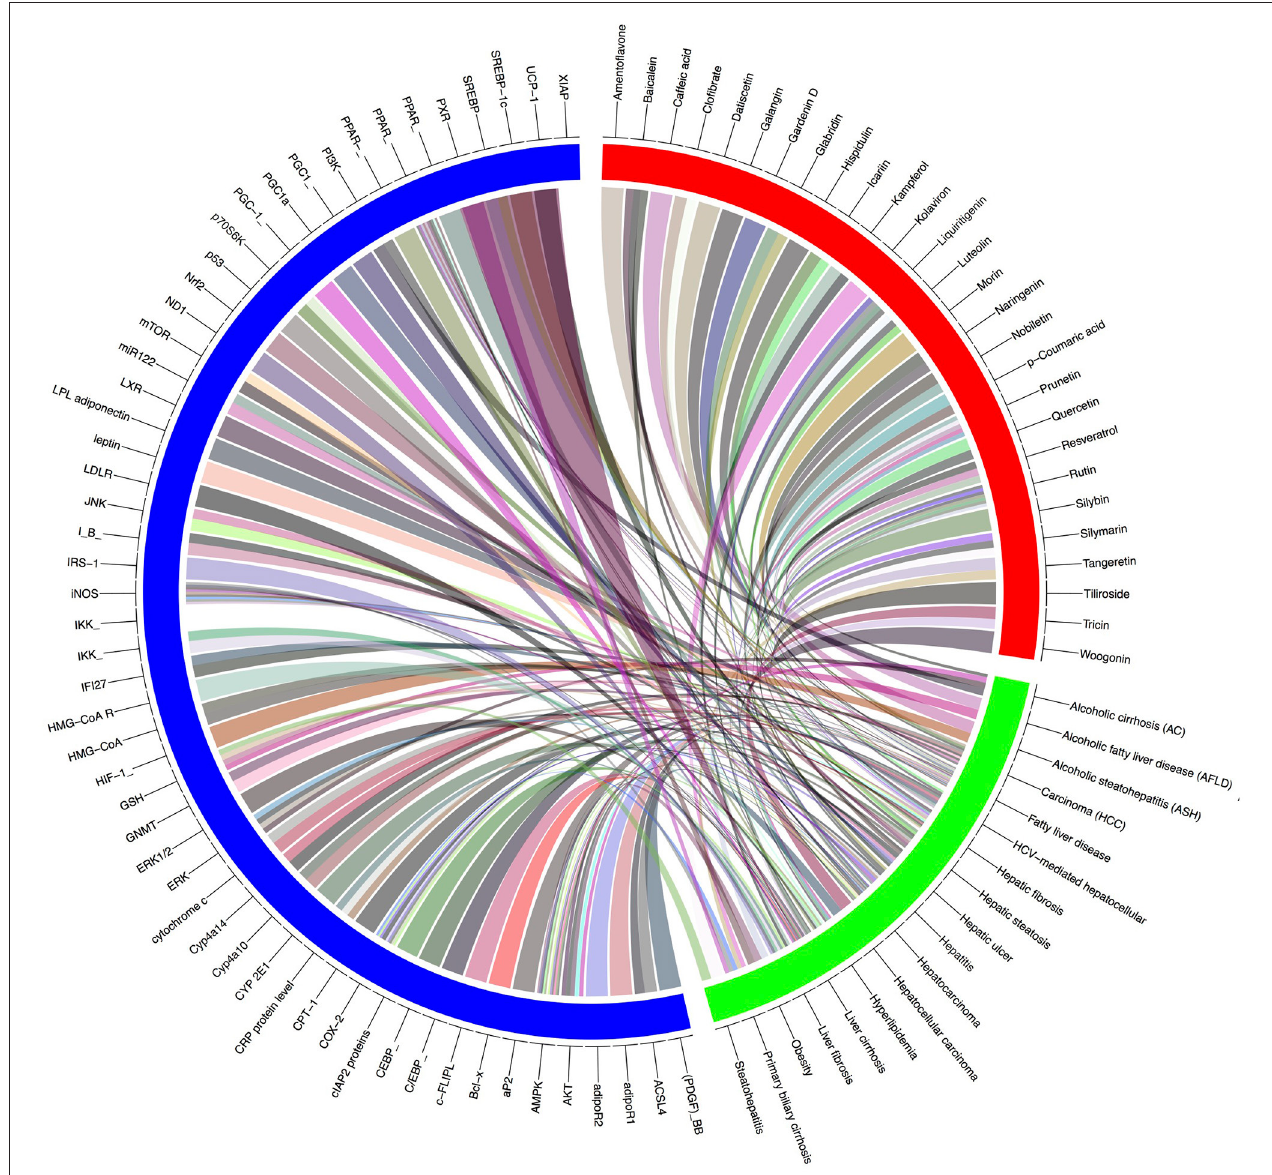
FIGURE 12 | Gene-modeling showing various hepatic diseases and associated genes with it. A tool named Circus on shiny Circos server generated this image. The blue band is showing various genes responsible for pathophysiological conditions, the green showing various hepatic complications and the red band shows the bioactive natural compounds possessive hepatoprotective activity. Various shades indicating the degree of relatedness between the various